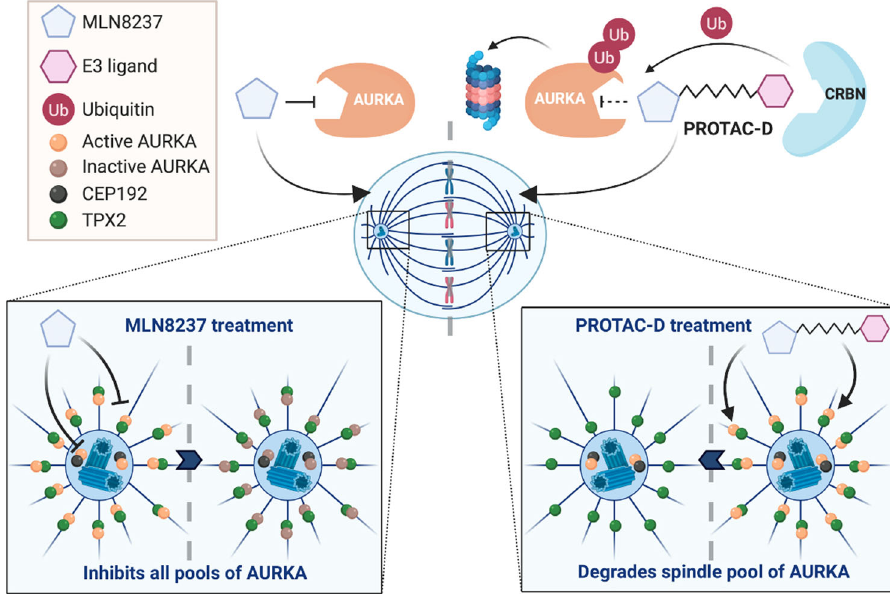
Fig. 8 Targeting of non-centrosomal AURKA functions by PROTAC-D. Schematic to illustrate the distinct actions of MLN8237 and PROTAC-D on AURKA pools in mitotic cells. Both centrosomal and spindle pools of AURKA are inhibitable by MLN8237, whereas PROTAC-D clears the spindle pool of AURKA whilst leaving active AURKA at the centrosome. Figure made in ©BioRender